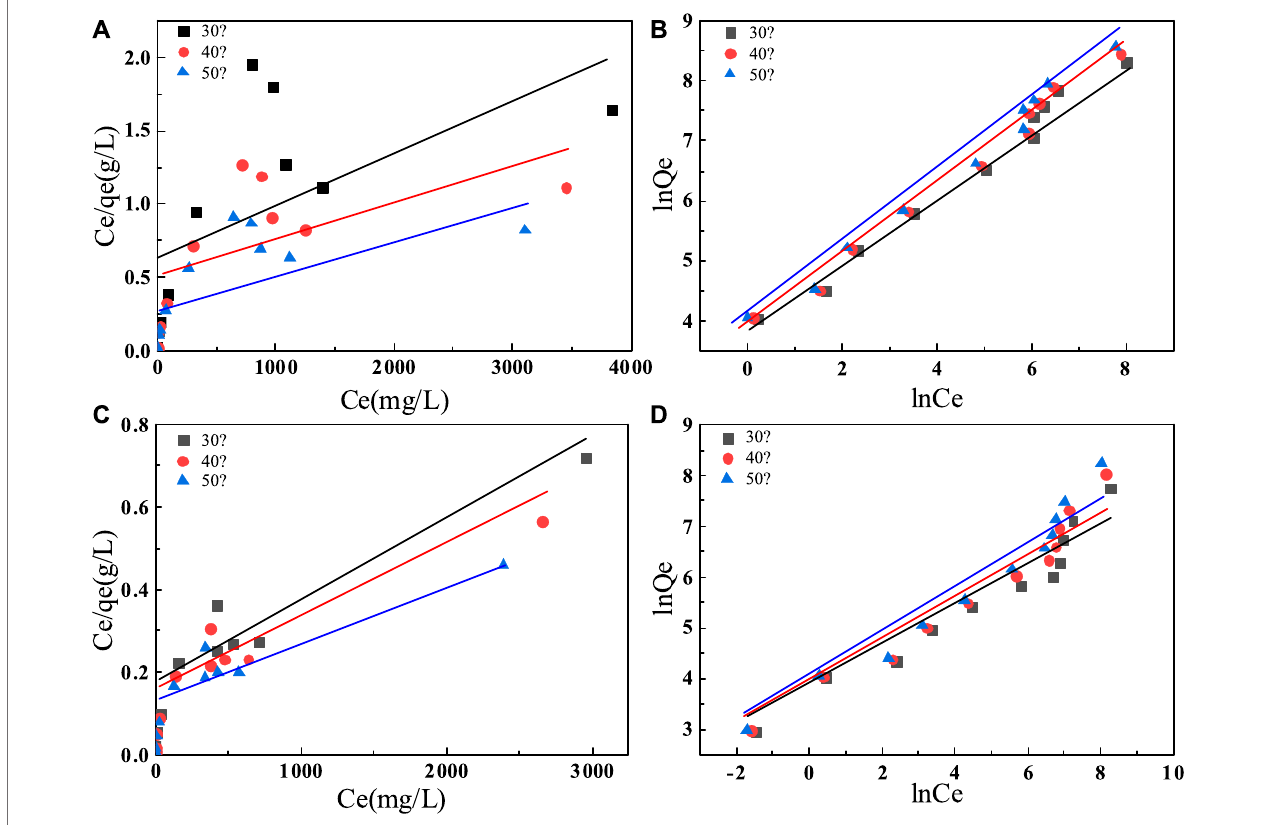
FIGURE 7 | Adsorption isotherm models of fl uoride on C-SAA (A) the Langmuir model; (B) the Freundlich model; adsorption isotherm model of fl uoride on C-SAAoa (C) the Langmuir model; (D) the Freundlich model.